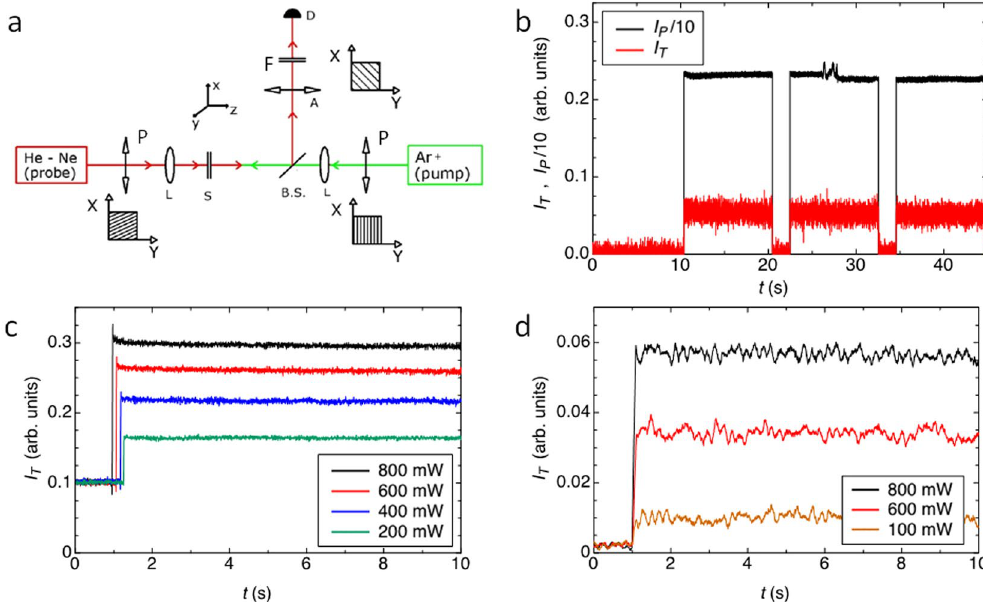
Figure 2. Experimental setup and transmitted intensity data. ( a ) Sketch of the experimental apparatus. The different optical components are indicated: P = polarizers, L = lens, S = sample, B.S. = beam splitter, A = analyzer, D = detector, F = filter. A pictorial description of the optical field direction is shown for each polarizer/analyzer. ( b ) Typical example of the observed response in terms of transmitted intensity (red line) to the pump optical field (black line) as the pump beam in turned on and off in time. The case of a AT-DD cell is reported in the case of polarizers set to the extinction orientation.Sampling time 4 ms. ( c , d ) Transmitted probe signal for different values of the pump power as a function of time, for the thermotropic 5CB/CB15 ( c ) and